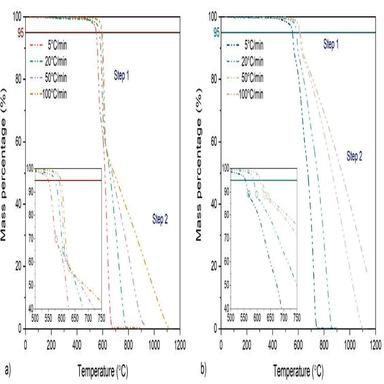
Conducted TGA experiments of a) PEEK and b) CF-PEEK in a 50 ml/min airflow with heating rates of 5, 20, 50 and 100 ◦C/min.